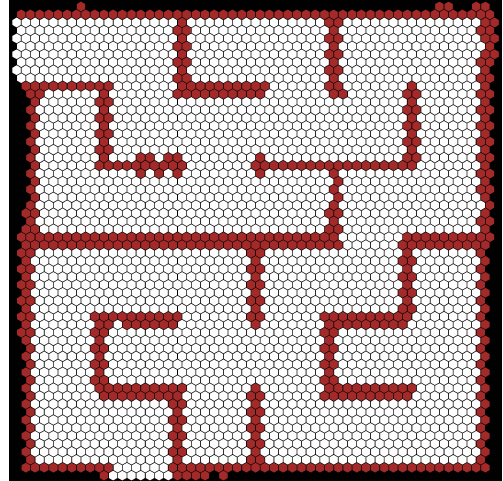
Figure 7. Map of the maze generated by the algorithm. The algorithm was tested on Ubuntu 20.04.4 LTS, AMD Ryzen 7 4800H CPU 1.4 GHz, RAM 32 GB (manufactured for Lenovo in China). On this hardware, one loop of the algorithm took an average of 1.5 × 10 − 2 s for a 360-point lidar and 2.9 × 10 − 2 s for a 1000-point